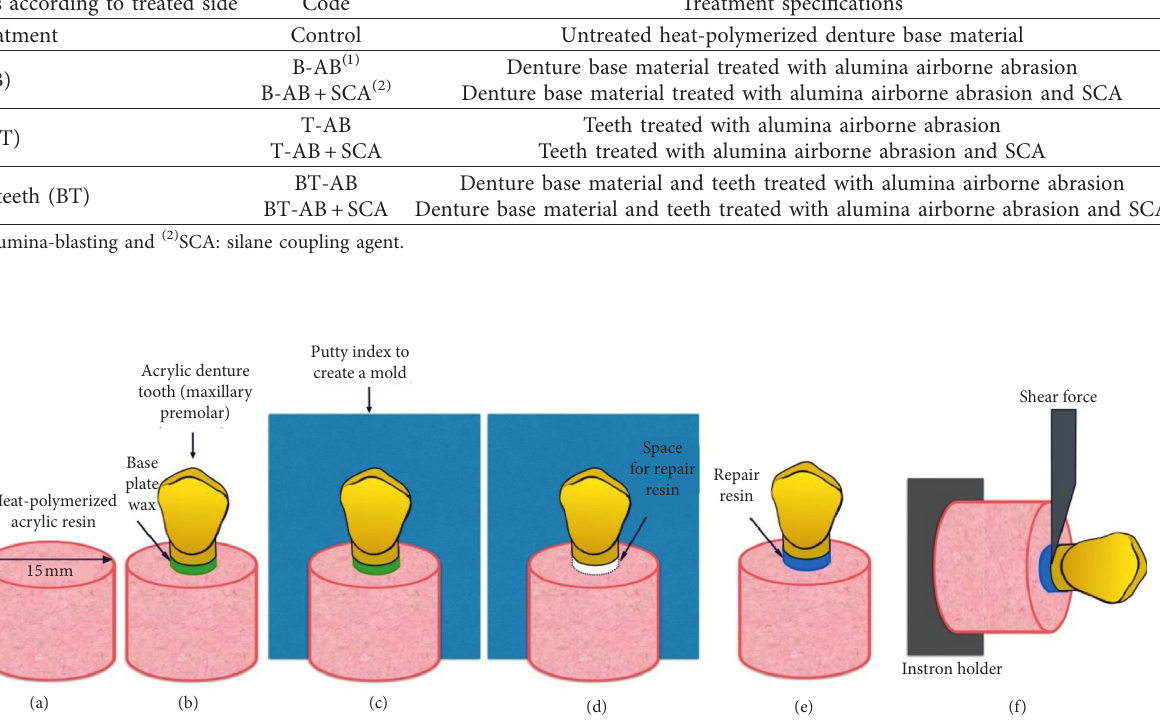
Figure 1: Diagrams representing specimen preparation and testing: (a) acrylic resin disc; (b) acrylic tooth waxed on resin disc; (c) repair mold preparation; (d) repair procedure and assembly of heat-polymerized acrylic disc and tooth; (e) repaired specimen; (f) shear bond strength test